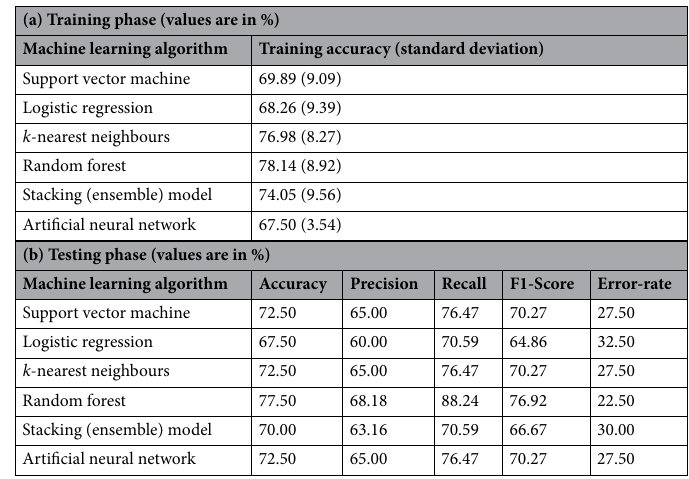
Table 1. The performance of the six machine learning algorithms for the case study.